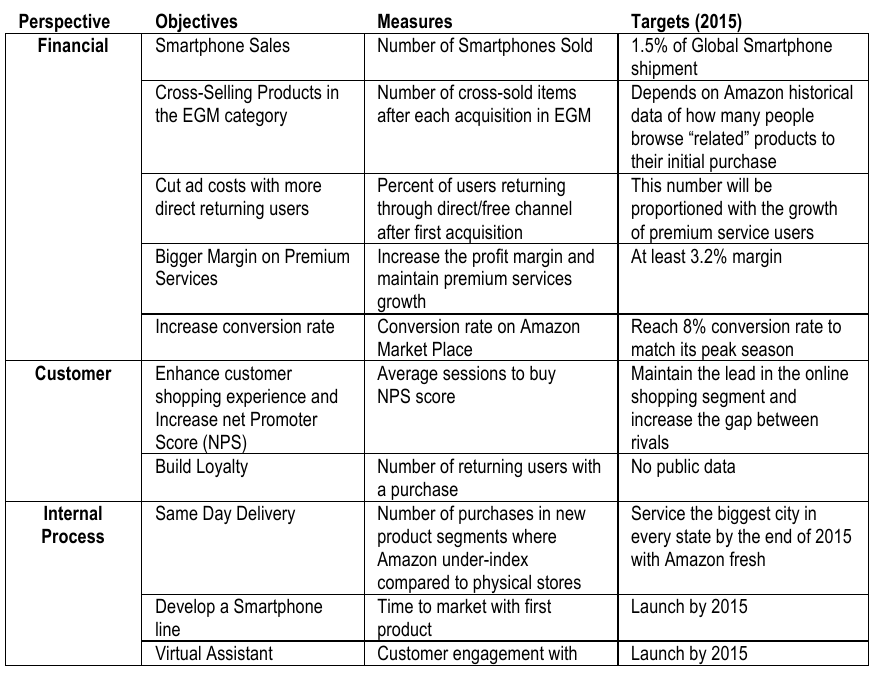
Table 3. Amazon Balanced